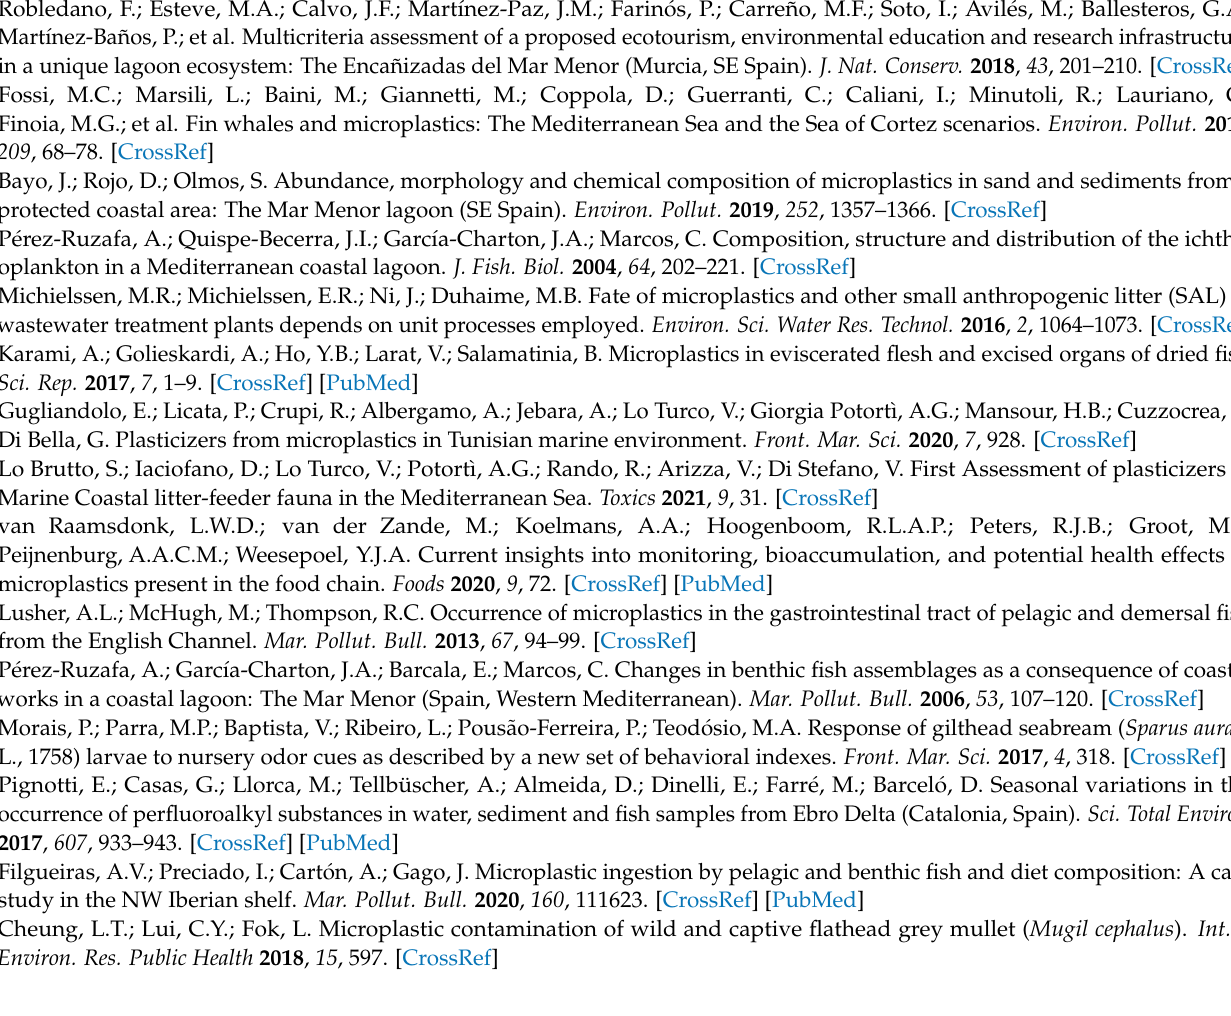
lagoon with the main fishery ports. Figure S2. (a) Fish length and (b) Fish wet weight measurements. Figure S3. Sample collection and processing: (a,b) stomach and intestine dissection, (c) vacuum filtration, (d) microscopic identification, (e) isolation of possible microplastics in 40-mm glass Petri dishes, and (f) FTIR identification. Figure S4. Average values of (a) fish length (FL), and (b) fish weight (FW), according to season and ANOVA tests. Figure S5. Cumulative distribution (%) of transparent and opaque microplastics according to CGS